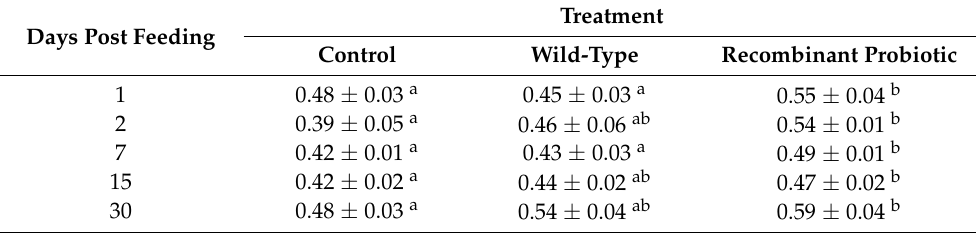
Table 4. Expression levels of CC chemokine mRNA in the intestine of Nile tilapia that were fed experimental diets.